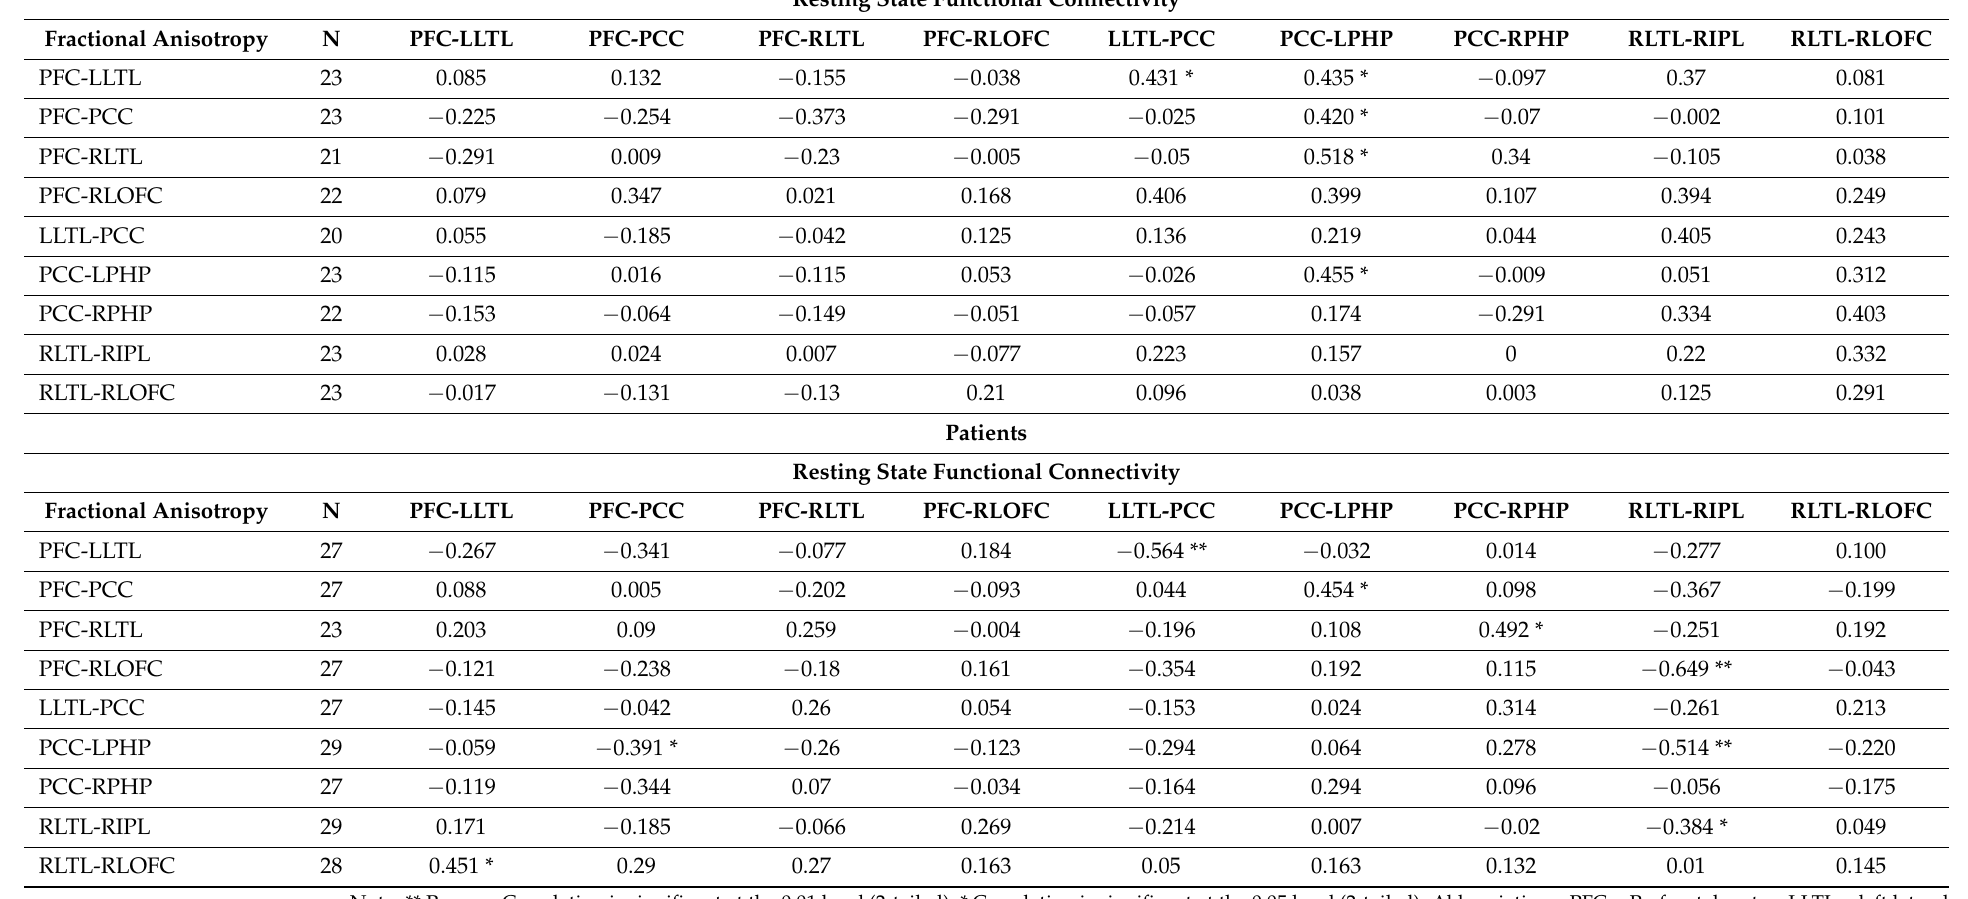
Table 2. Pearson correlations (r) between resting state functional connectivity and fractional anisotropy for region pairs. Controls Resting State Functional